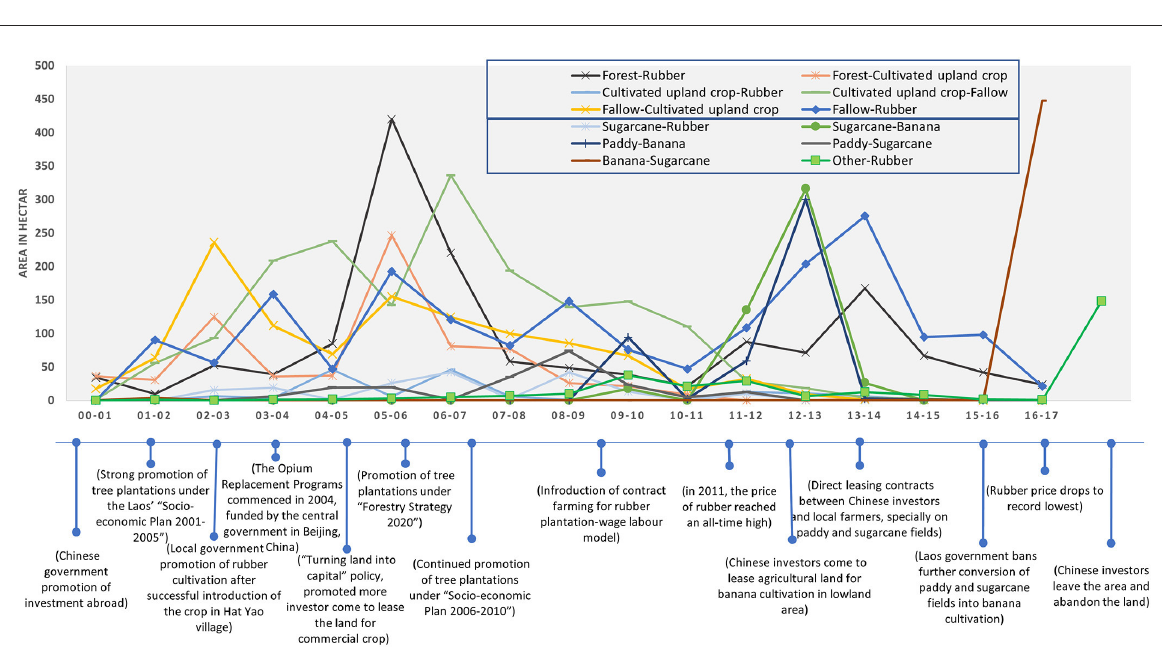
the villages changed to sugarcane between 2002 and